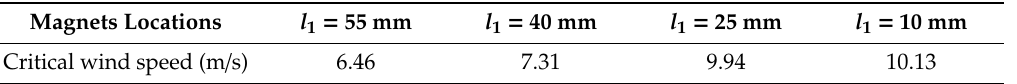
Table 4. Predictions of the critical wind speed of an energy harvester with di ff erent magnet positions. Magnets